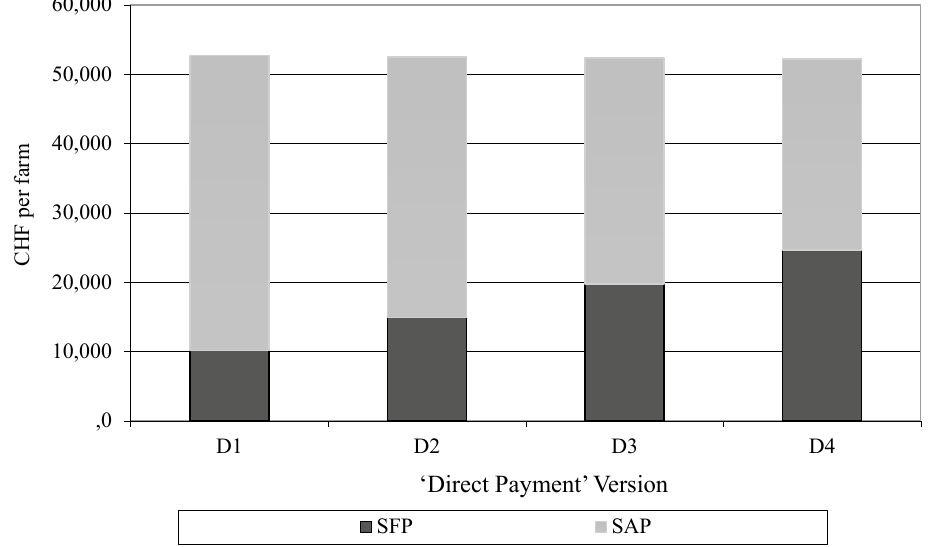
Figure 4. Ratio of SAP to SFP averaged over all